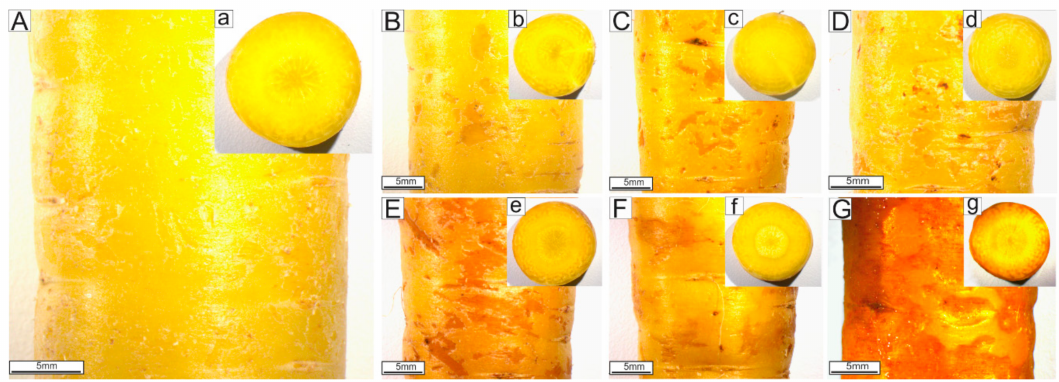
Figure 3. Details of yellow carrots 15 days after the application of different edible coatings and stored at 2 ◦ C 95–100% RH. ( A , a ) Control; ( B , b ) chitosan 1%; ( C , c ) chitosan 3%; ( D , d ) chitosan 5%; ( E , e ) carnauba wax 0.5%; ( F , f ) carnauba wax 1%; ( G , g ) carnauba wax